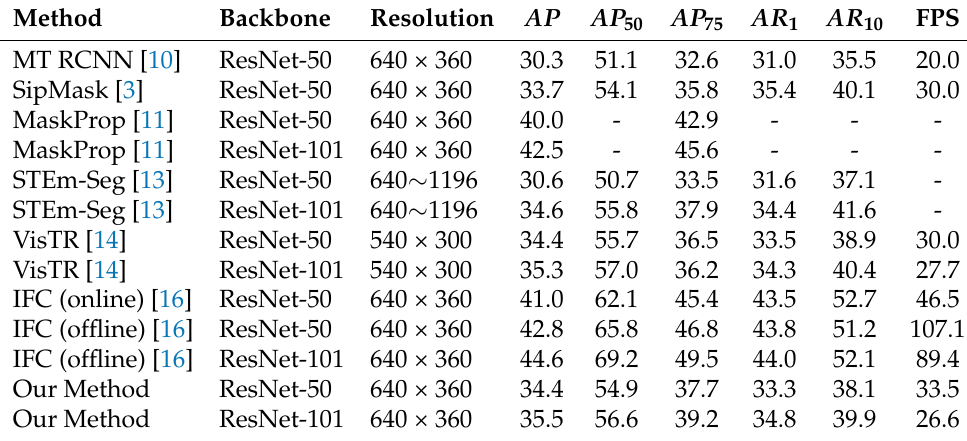
Table 1. Performance comparison on the Youtube-VIS validation set. All models are pre-trained on MS COCO. We test MaskTrack RCNN, SipMask and our method on the same machine. For other methods, we report the results from the original